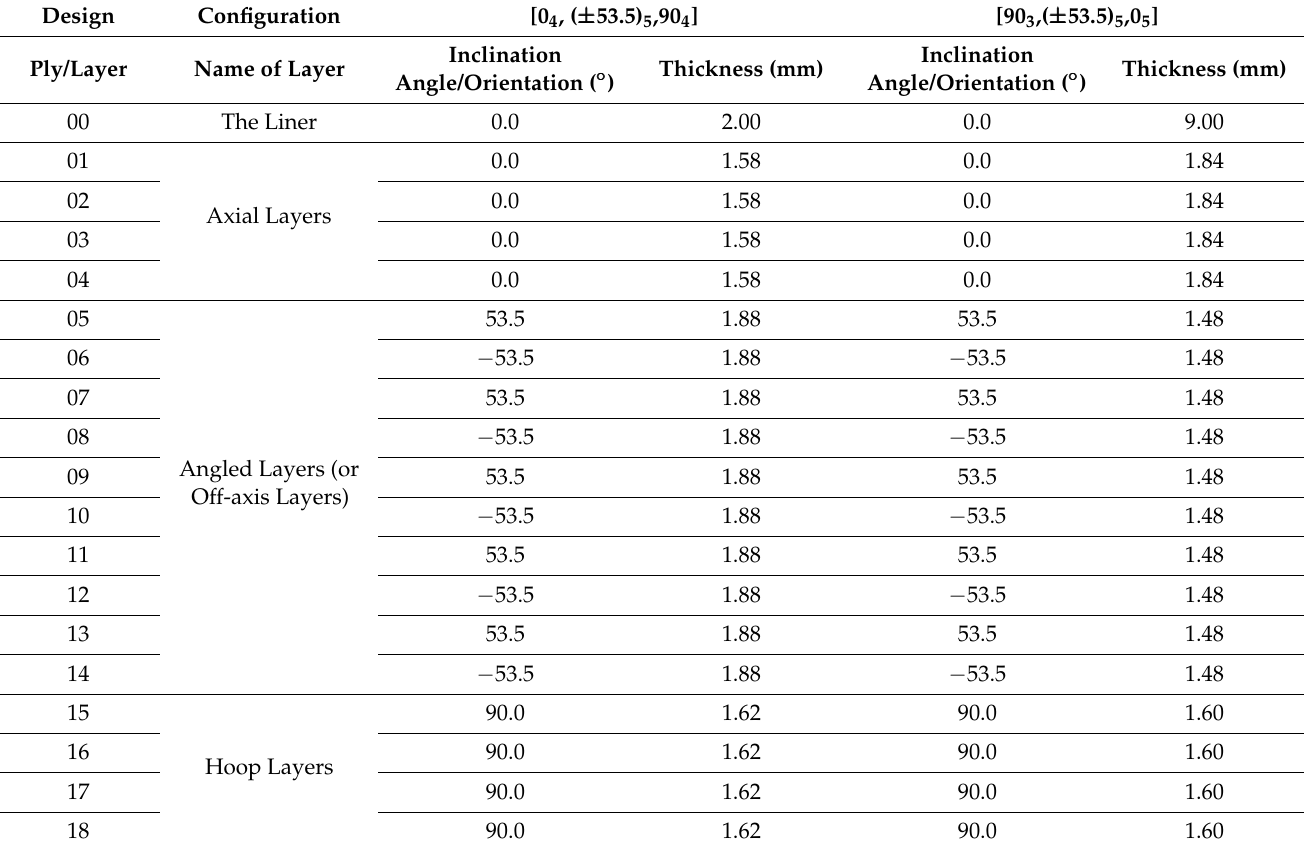
Table 7. Lay-up/ply inclination angle for local design for the [0 4 ,( ± 53.5) 5 ,90 4 ] and [90 3 ,( ± 53.5) 5 ,0 5 ]